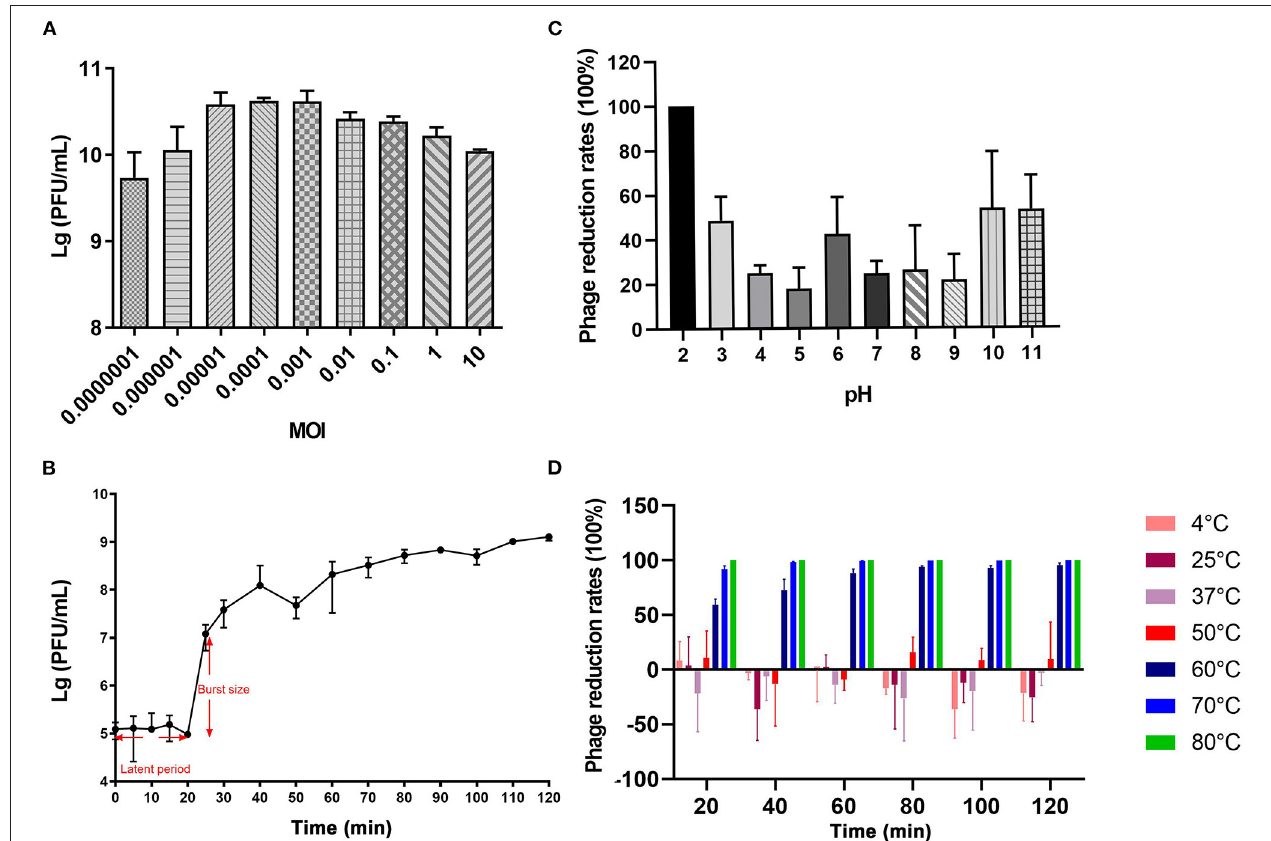
FIGURE 2 | Growth characteristics and stability tests of vB_CbrM_HP1. (A) The optimum MOI of phage vB_CbrM_HP1. The titer of vB_CbrM_HP1 at nine different multiplicities of infection (MOIs) at 7h at 37 ◦ C with 180 rpm/min. (B) The one-step growth curve of phage vB_CbrM_HP1. When the MOI was 0.1, the titer of vB_CbrM_HP1 changed within 2h. (C) The pH stability of phage vB_CbrM_HP1. The reduction rates of vB_CbrM_HP1 in SM buffer of different pH ( 2–11) values for 2h at 37 ◦ C. (D) The temperature stability of phage vB_CbrM_HP1. The reduction rates of vB_CbrM_HP1 at different temperatures (4–80 ◦ C) over 2h. The means and standard deviations are represented as points with error bars ( n =